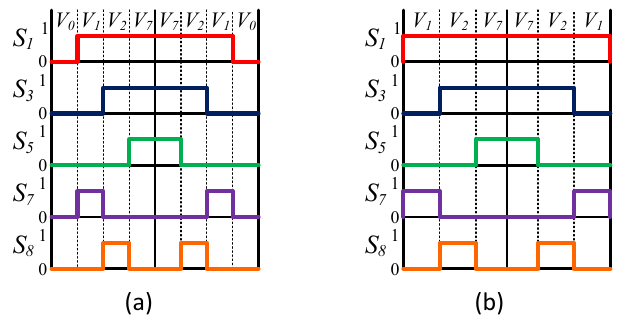
Figure 6. Switching patterns for ( a ) CSSVM and CASVM, and ( b )